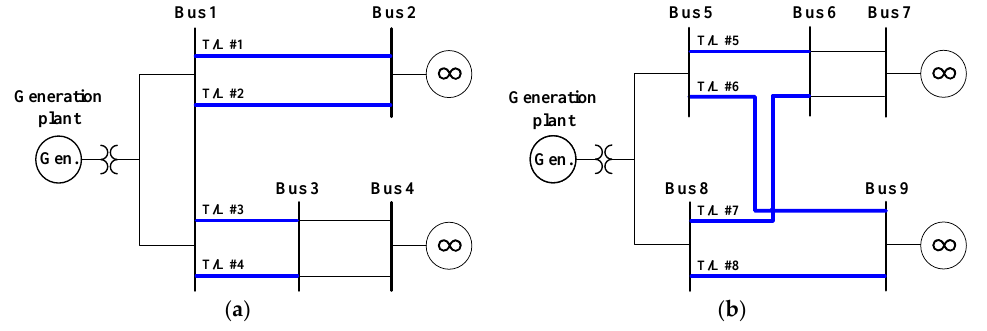
Figure 2. Single-line diagram of the transmission system: ( a ) Single-line diagram of the 154 kV transmission system; ( b ) Single-line diagram of the 345 kV transmission system.